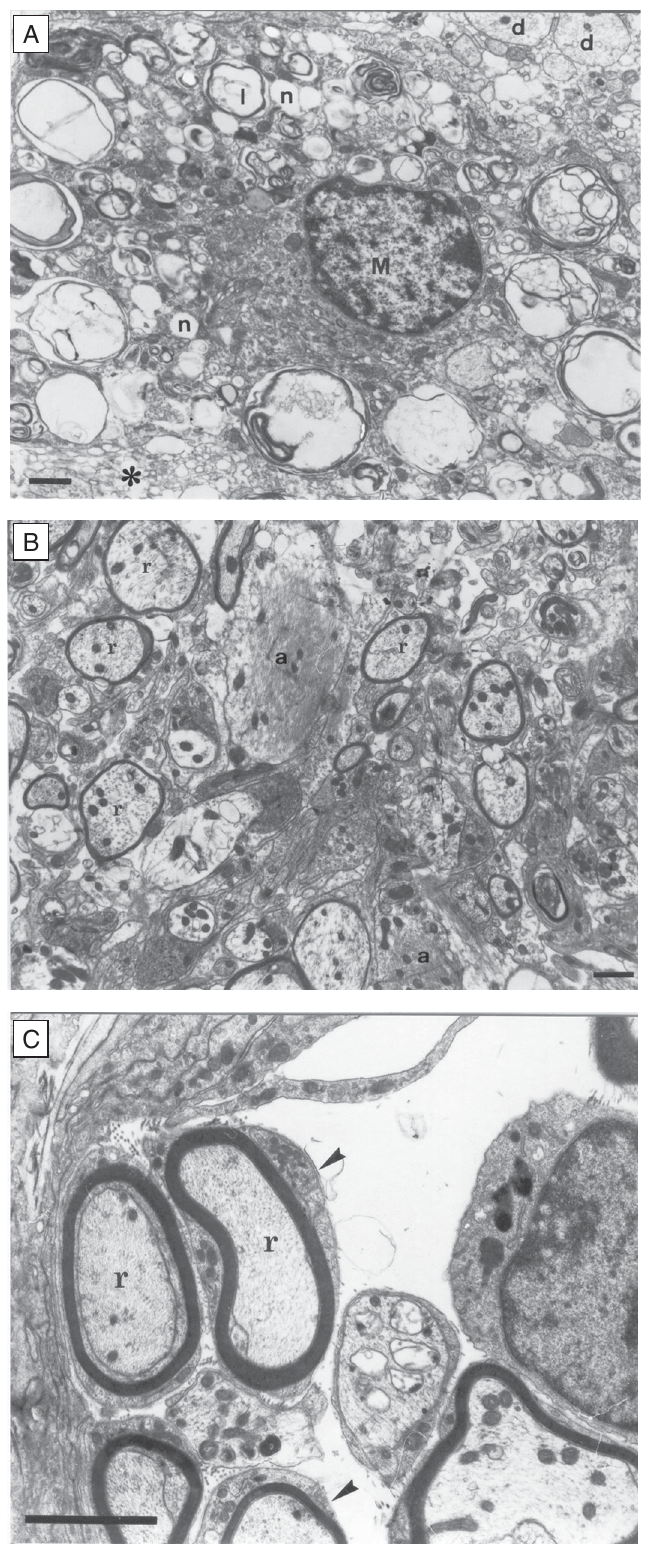
Figure 1. Group IV. A , 7 days after ethidium bromide injection. A macrophage (M) containing myelin at differ- ent stages of degradation, including lamellae (l) and neutral fat droplets (n) in an area of enlarged extracel- lular space filled with myelin debris (asterisk) and de- myelinated axons (d). Bar = 1 µm. B , 15 days after ethidium bromide injection. Oligodendrocyte-remyeli- nated axons (r) associated with hyperthrophic astro- cytic processes (a). Bar = 1 µm. C , 15 days after ethi- dium bromide injection. Axons (r) remyelinated by Schwann cells. Note that portions of Schwann cell cyto- plasm (arrowheads) surround these axons. Bar = 2